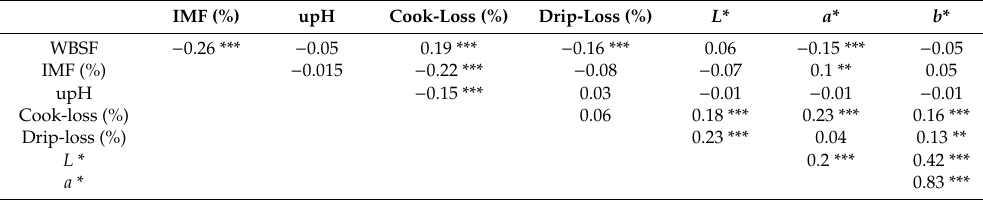
Table 1. Pearson correlation coe ffi cients between quality traits of beef